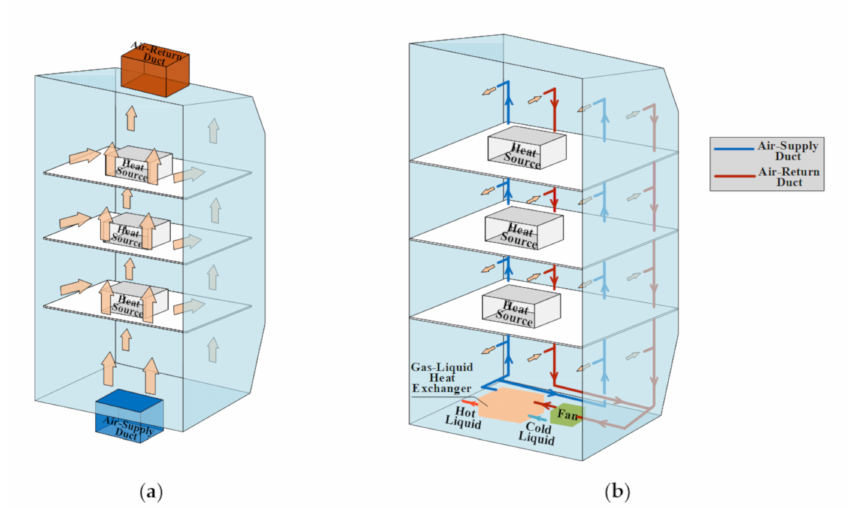
Figure 1. Diagram of traditional air cooling system. ( a ) Concentrated air supply cooling mode; ( b ) Built-in gas-liquid heat exchanger air cooling